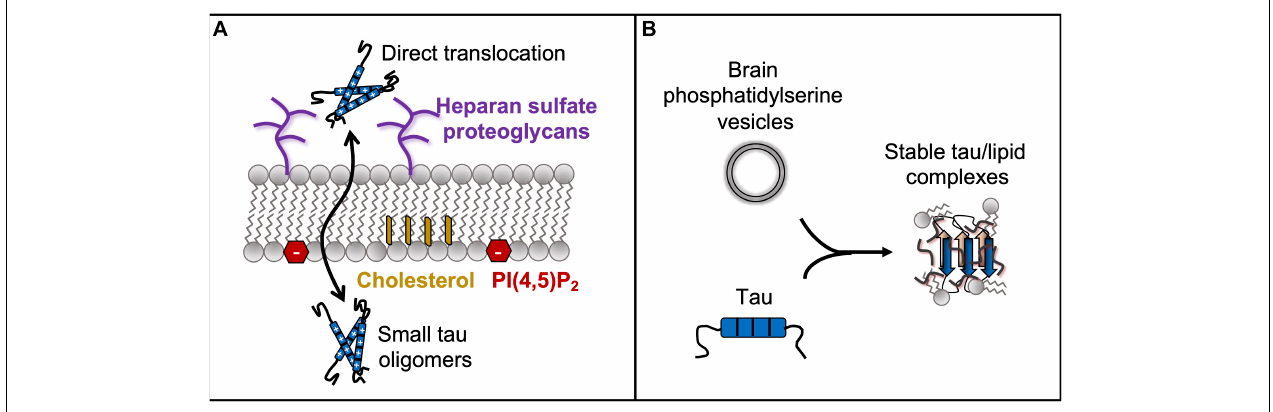
FIGURE 4 | Tau has favorable interactions with entire lipid molecules, including the phospholipid heads and tails, which is inferred by tau’s direct translocation across the membrane (A) and by formation of stable tau-lipid complexes (B)